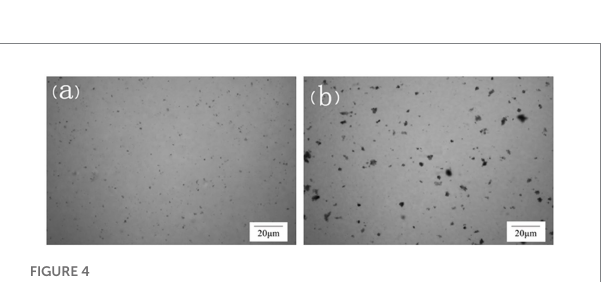
FIGURE 4 Electron microscope images of free bacteria (A) and LBMs (B)